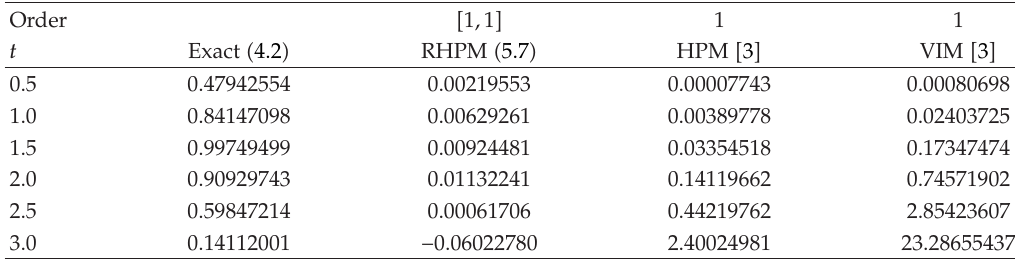
Figure 2: Exact solution (cid:3) 5.2 (cid:4) (cid:3) diagonal cross (cid:4) for Van der Pol oscillator problem (cid:3) 5.1 (cid:4) and its first order approximate solutions obtained by RHPM (cid:3) 5.7 (cid:4) (cid:3) solid line (cid:4) , HPM (cid:5) 3 (cid:6) (cid:3) dash-dot (cid:4) , and VIM (cid:5) 3 (cid:6) (cid:3) solid diamond (cid:4) . Table 2: Comparison of the relative error between exact solution (cid:3) 5.2 (cid:4) for (cid:3) 5.1 (cid:4) and its first order approximate solutions given by RHPM (cid:3) 5.7 (cid:4) , HPM (cid:5) 3 (cid:6) , and VIM (cid:5) 3 (cid:6)